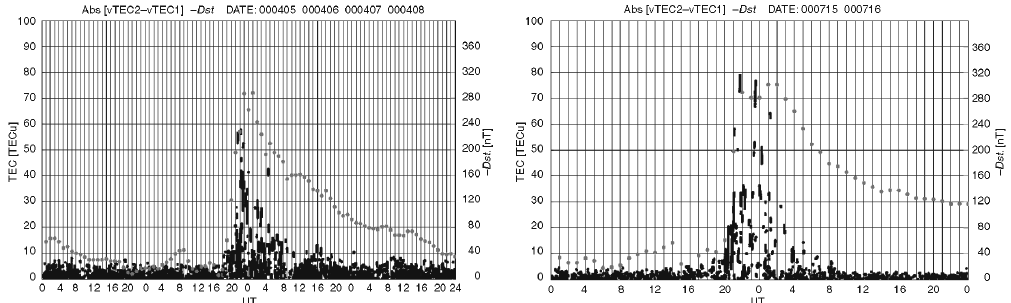
Fig. 18.4. ∆ TEC quantities and – Dst index values as a function of UT for April 05-08 and for July